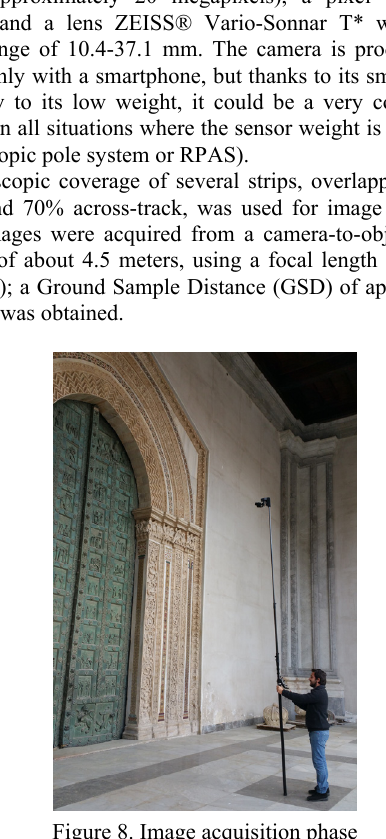
Figure 6. The topographic survey